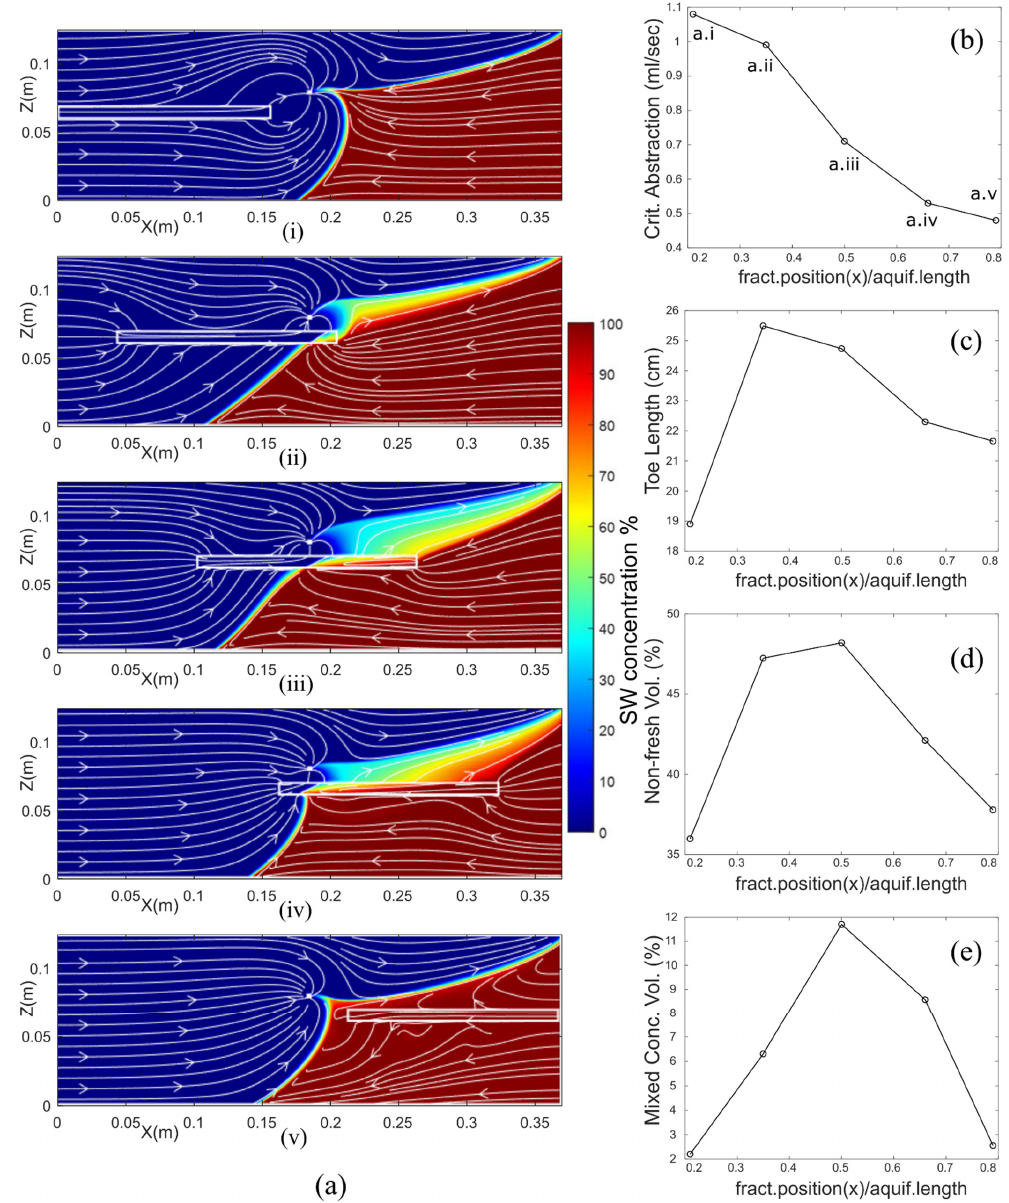
Figure 9. Simulated ( a ) critical SW concentration fields alongside their corresponding values of ( b ) critical abstraction rates, ( c ) toe length, ( d ) non-fresh and ( e ) mixed-concentration volume fractions, demonstrating the impact of fracture position (x) on the saltwater upconing mechanism.